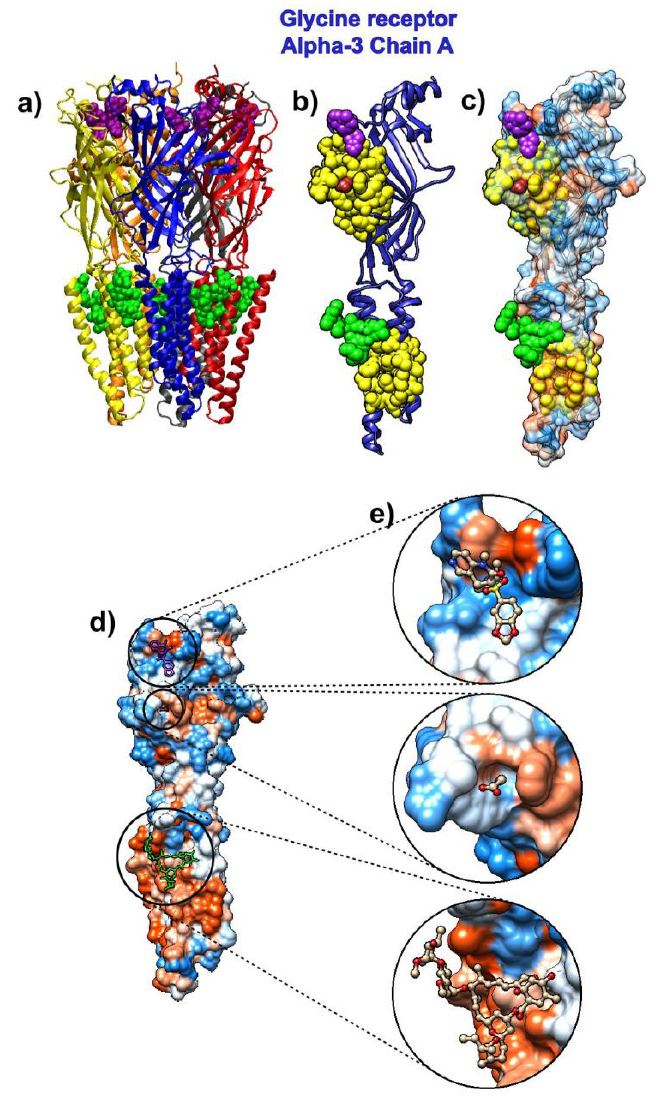
Figure 2. Ivermectin and its target protein, human glycine receptor alpha-3 (pdb id 5vdh). ( a ) Five pentamer chains (A to E) are represented as ribbons. Ivermectin is represented via green atoms. Glycine molecules are brown and represented as atoms, and 7C6 molecules are represented as purple atoms. ( b ) Chain A from human glycine receptor Alpha-3 is represented as a blue ribbon. SAGNM predictions are depicted as yellow atoms. Ivermectin is represented via green atoms. The glycine molecule is brown and represented as spherical atoms. The 7C6 molecule is represented as purple atoms. ( c ) Chain A from human glycine receptor alpha-3 is depicted as a transparent hydrophobic surface. SAGNM predictions are yellow, glycine molecule is represented as brown, 7C6 molecule as purple, and ivermectin as green atoms. ( d ) Chain A from human glycine receptor alpha-3 is depicted as an opaque hydrophobic surface. The glycine molecule is represented as brown balls and sticks, the 7C6 molecule is represented as purple, and ivermectin as green balls and sticks. ( e ) The three insets show glycine, 7C6, and ivermectin molecules inside the hydrophobic pockets on the surface of the chain A of human glycine receptor alpha-3. The figure is produced with the VMD and UCSF Chimera programs